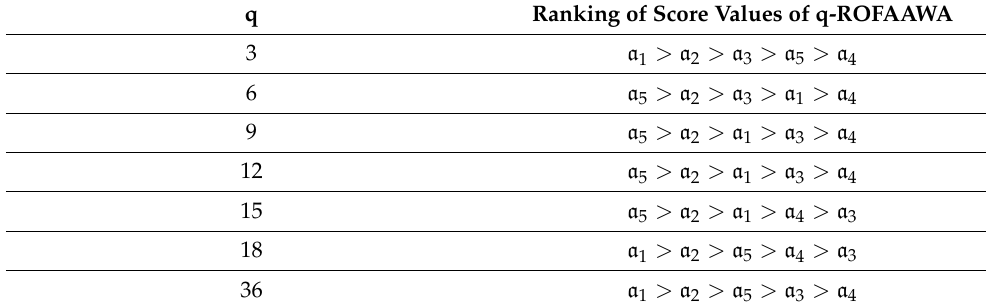
Table 8. Ranking of score values by changing q.